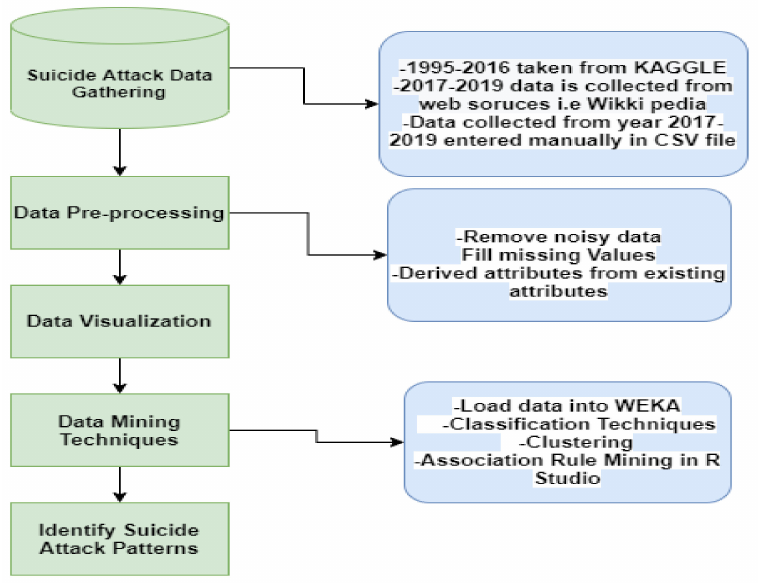
Figure 6. The overall process of the proposed method for suicide attack analysis and